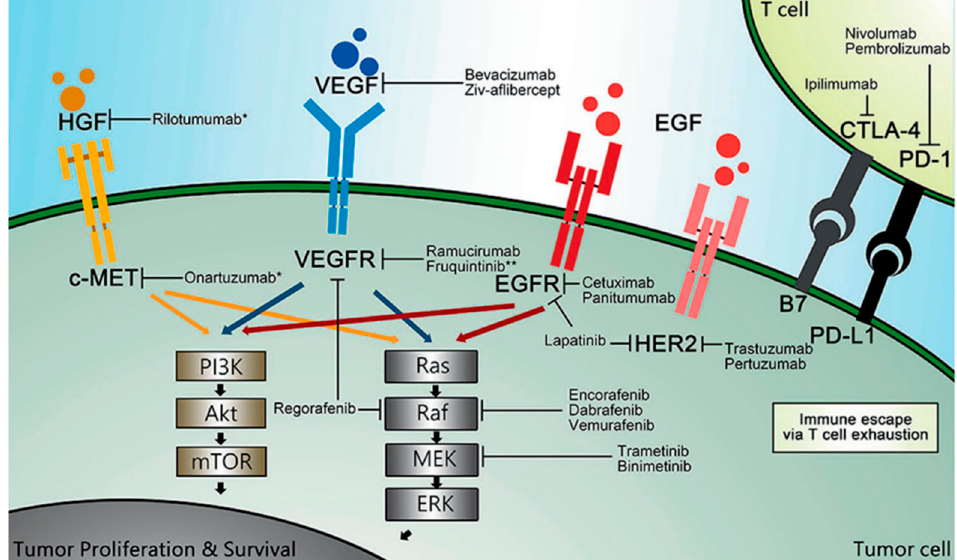
Figure 2. Overview of National Comprehensive Cancer Network (NCCN)-recommended targeted agents. HGF: hepatocyte growth factor; c-MET: mesenchymal–epithelial transition factor; VEGF: vascular endothelial growth factor; VEGFR: vascular endothelial growth factor receptor;